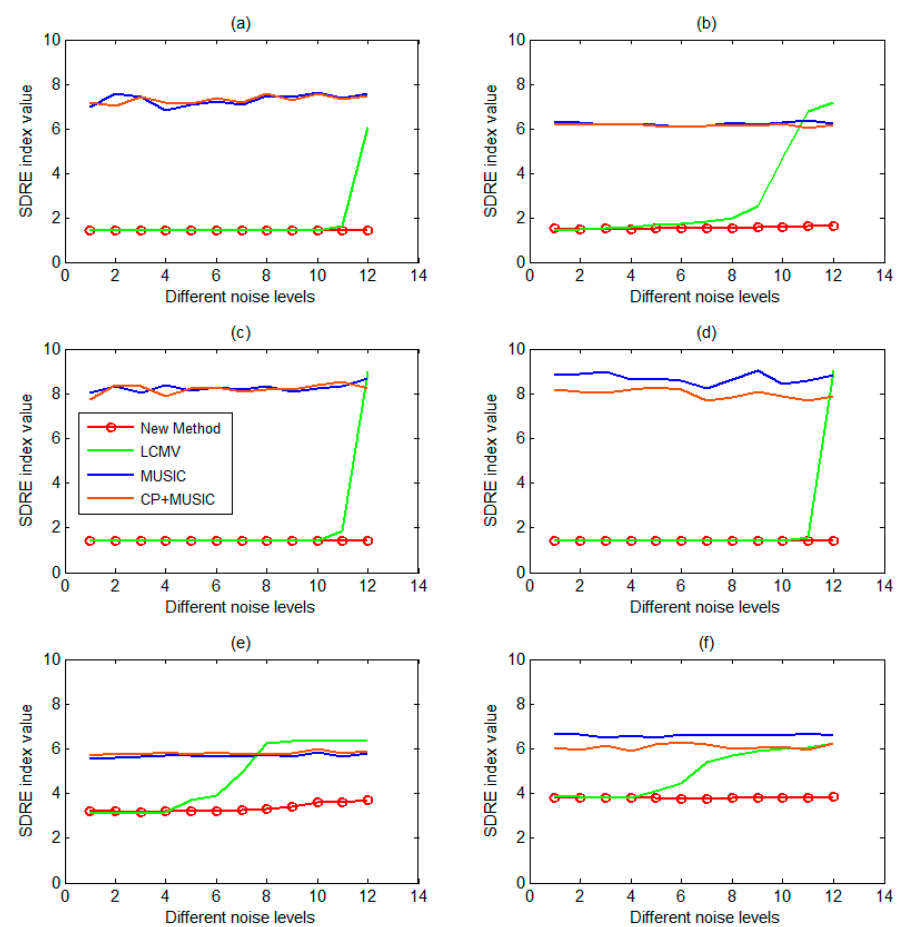
Figure 4. The source localization results of four different algorithms (the proposed new method, LCMV, MUSIC, and CP+MUSIC) were compared based on six different locations sources, in which the horizontal coordinates of each subgraph represented different noise levels, and the ordinates represented the mean of different SDRE values with 100 random results at the same noise level. ( a ) The mean of SDRE values varies with different noise levels based on the real source located in the right frontal lobe; ( b ) The mean of SDRE values varies with different noise levels based on the real source located in the right lateral temporal lobe; ( c ) The mean of SDRE values varies with different noise levels based on the real source located in the right parietal lobe; ( d ) The mean of SDRE values varies with different noise levels based on the real source located in the right occipital lobe; ( e ) The mean of SDRE values varies with different noise levels based on the real source located in the right mesial temporal lobe (right hippocampus); ( f ) The mean of SDRE values varies with different noise levels based on the real source located in the left mesial temporal lobe (left hippocampus).